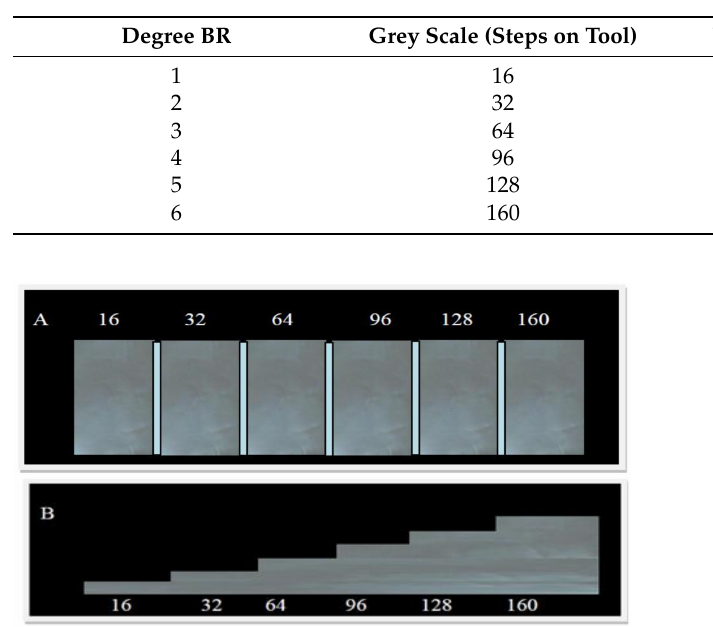
Figure 1. Surgical procedure: Control Group: ( a ) Full-Thickness triangular flap; ( b ) Tooth extrac- tion; ( c ) Alveolus cleaning for natural clot formation. Experimental Group: ( d ) Alveolus cleaning; ( e ) CaSO 4 + PRGF graft; ( f ) Graft in the alveolus. To measure bone regeneration radiographically (Ro/BR), a homemade grey standard- ized aluminum scale (GSAS) was used. Each step of the scale was numbered from 1 to 6 cor- responding to a difference of 16.66%, until a 100% recording the results in Table 1 (Figure 2). Table 1. Bone RO percentages, where number 1 represents the lowest and 6 the highest.